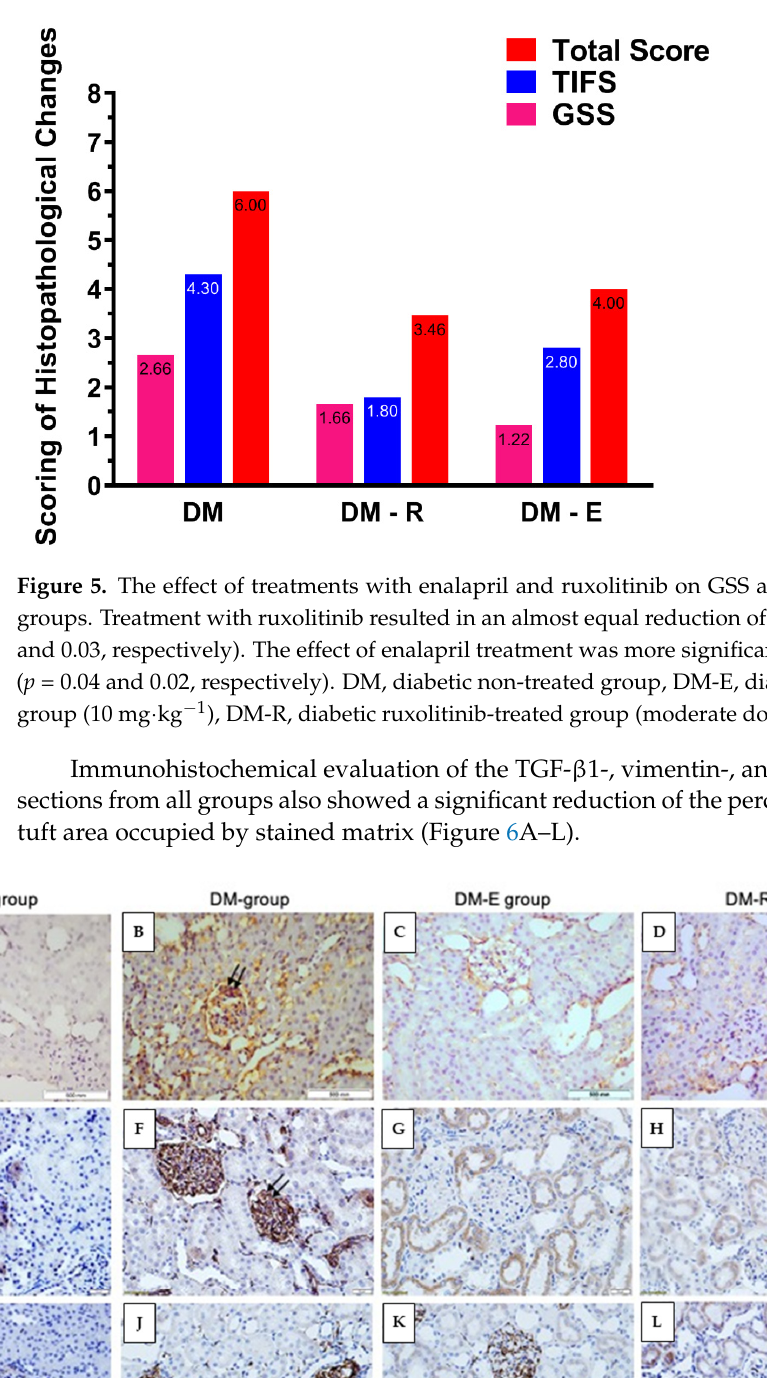
Figure 6. Immunohistochemistry analysis of fibronectin ( A – D ), TGF- β 1 ( E – H ), and vimentin ( I – L ) expression in the stud- ied groups. Representative pictures after immunostaining for fibronectin, TGF- β 1, and vimentin in the Ctrl group ( A , E , I ), DM group ( B , F , J ), enalapril group ( C , G , K ), and DM-R group ( D , H , L ). Note that glomeruli in the DM group show evidence